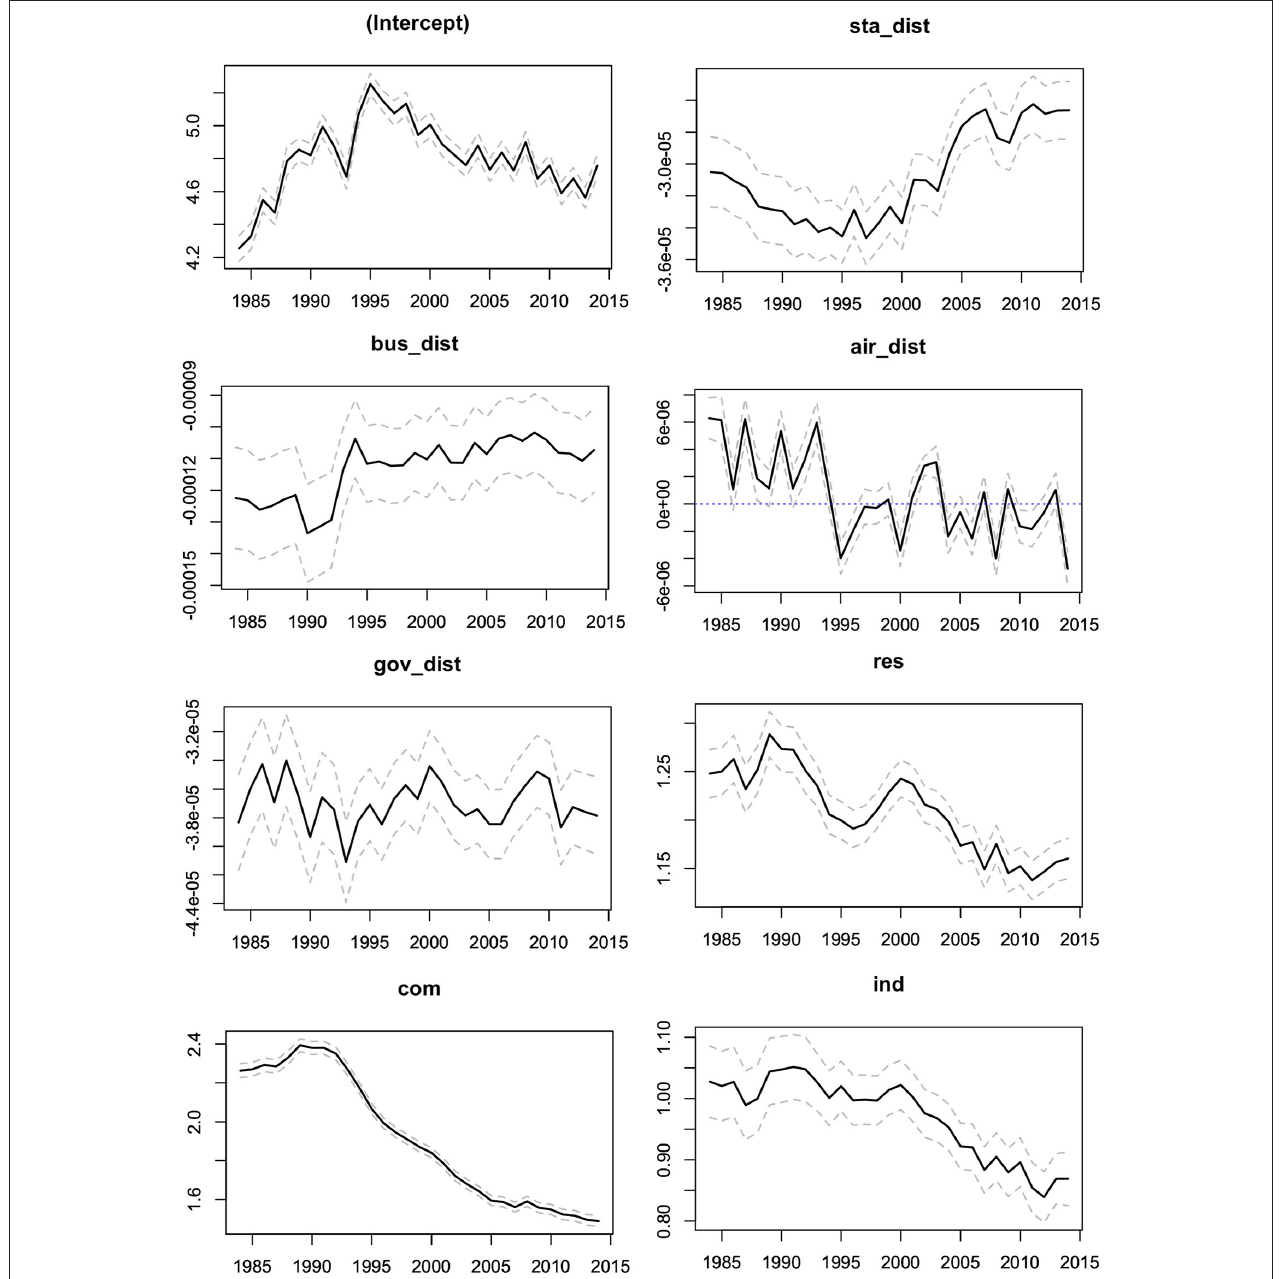
FIGURE 6 | Coefficients estimated from SM_GL. Solid line represents the coefficient estimates and dashed lines represent the upper and lower limits of the 95 percent confidence intervals.